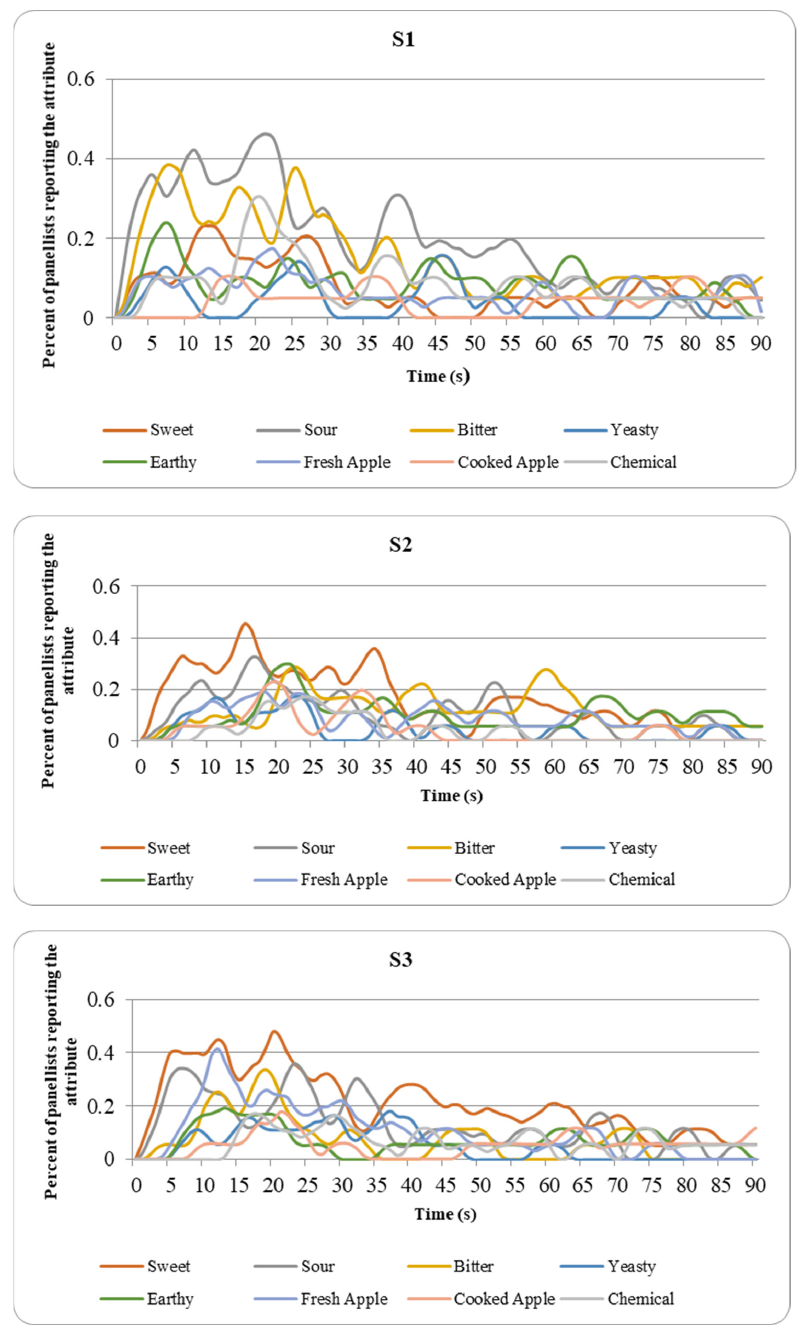
Figure 1. Temporal-check-all-that-apply of the sweet ciders.